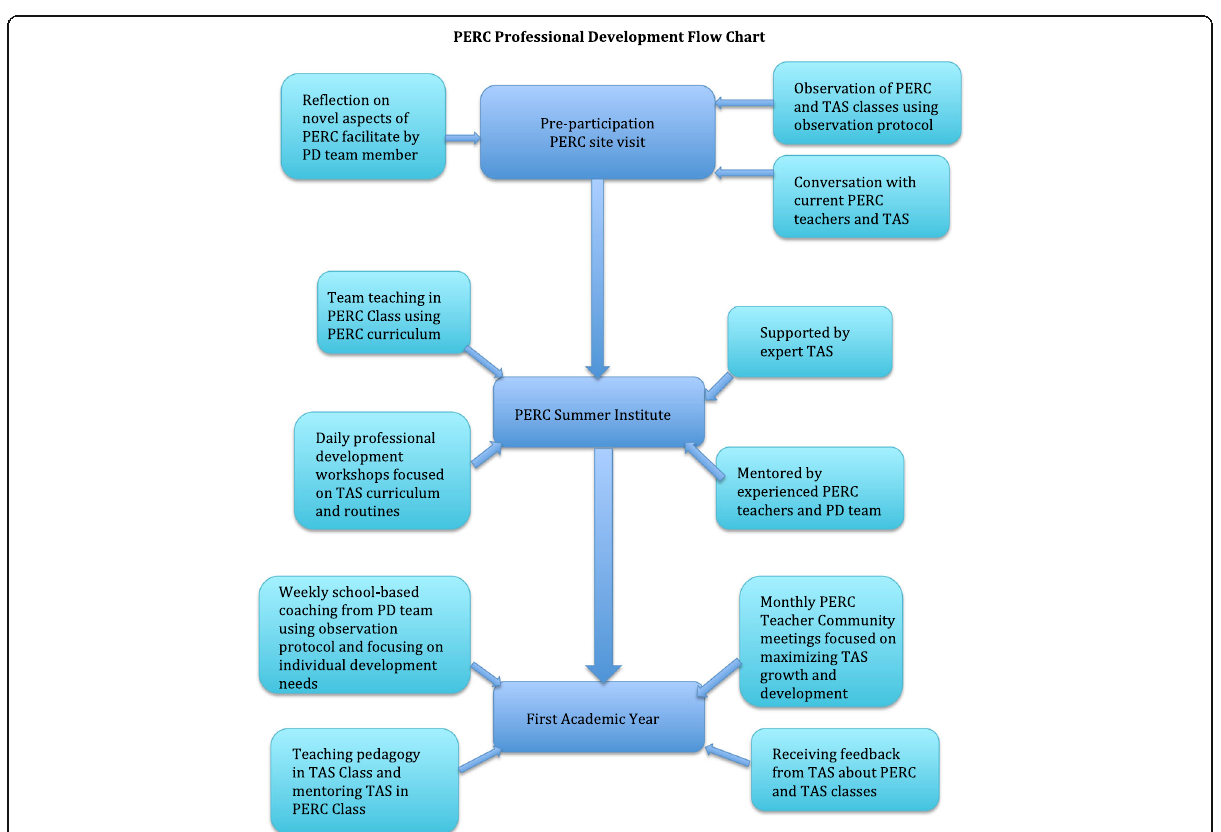
Fig. 1 PERC professional development flow